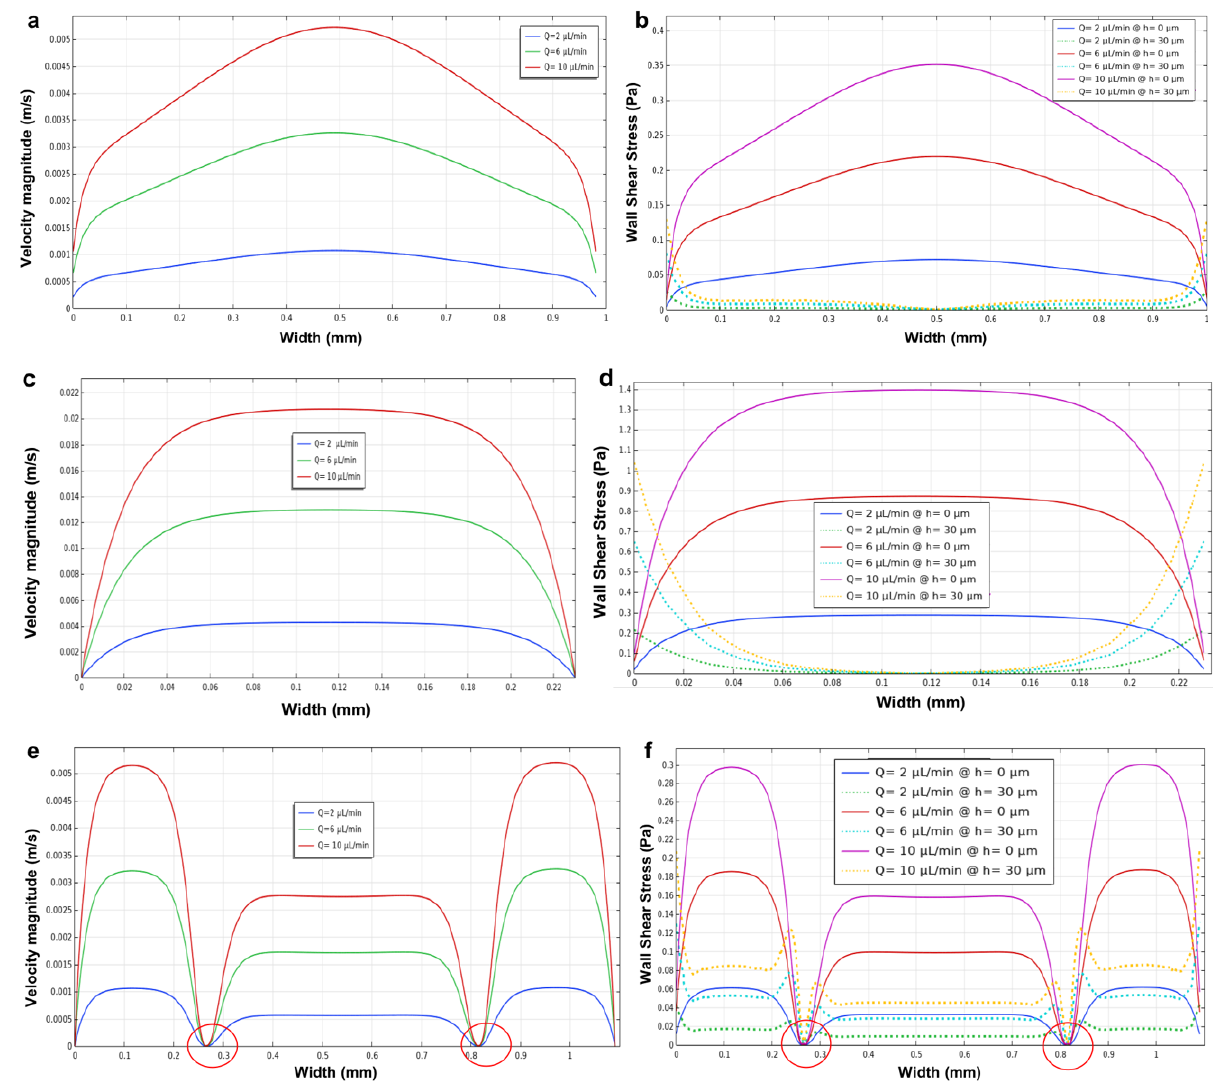
Figure 10. The influence of height in microfluidic devices using different heights of 30 and 60 μm. The velocity magnitude and wall shear stress profile at the bottom microchannels (h = 0 µm) and in the middle of the microchannels (h = 30 µm). ( a , b ) the circular microchamber; ( c , d ) the longitudinal microchannel; and ( e , f ) the three parallel microchannels with a height of 60 µm using flow rates of 2, 6, and 10 µL/min for the side channels. Red circles in ( e , f ) highlight the velocity and shear stress fluctuations near the micropillar structures.